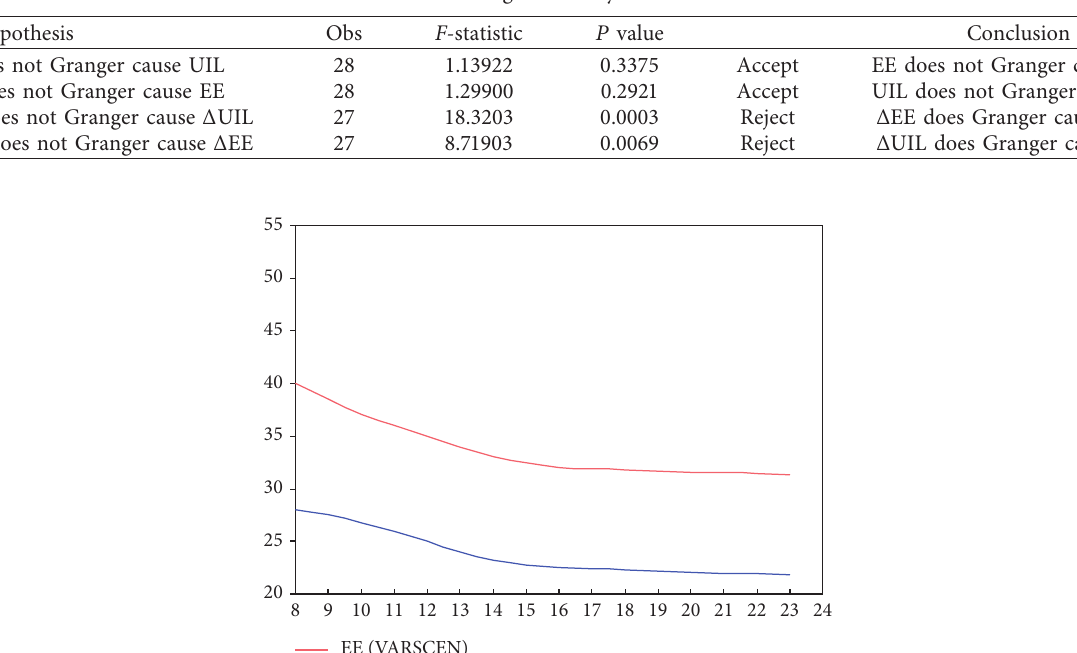
Table 9: Granger causality test results.